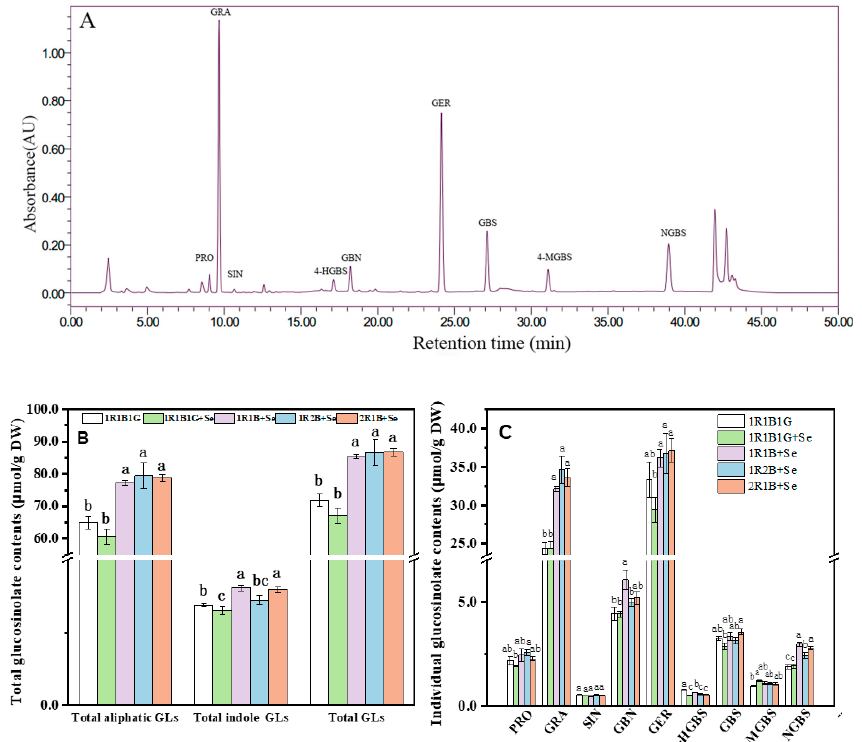
Figure 3. High-Performance Liquid Chromatography of identified glucosinoaltes from broccoli sprouts ( A ) the total glucosinolate contents ( B ) and the individual glucosinolate contents ( C ) in broccoli sprouts. The letters marked in all figures indicate the significance of the difference ( p ≤ 0.05, Duncan’s test).